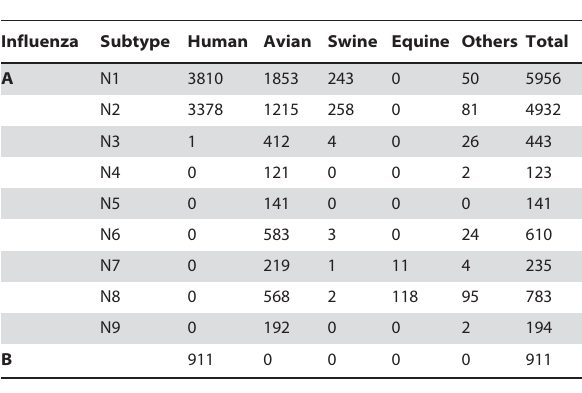
Table 4. Host distribution of neuraminidase (NA) sequences in influenza A and B